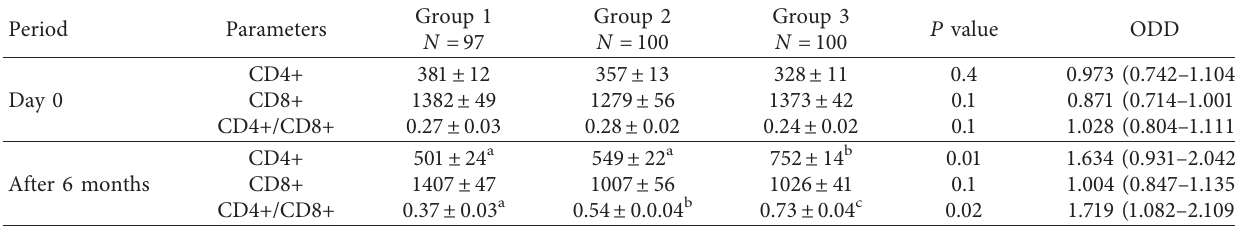
Table 3: Variation of LT CD4+ and LT CD8+ in different groups.